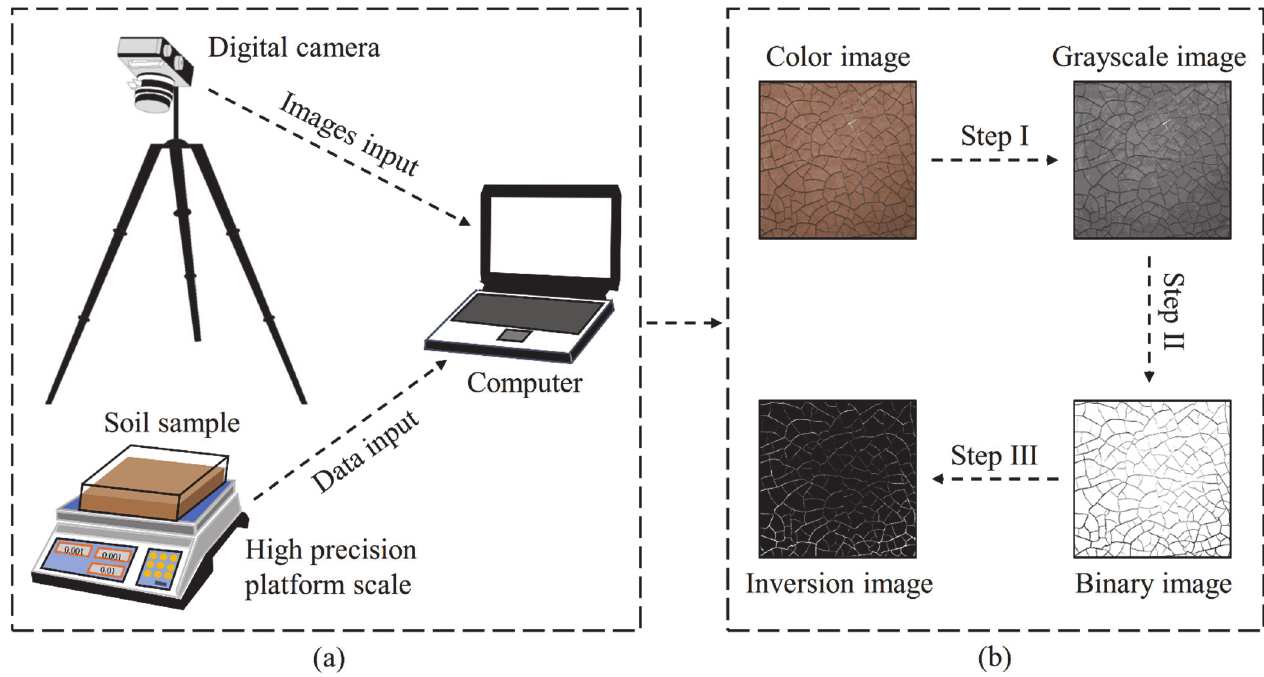
Figure 2. A schematic diagram of the sample device and processing process: ( a ) Data and images acquisition system; ( b ) Image processing. acquisition system; ( b ) Image